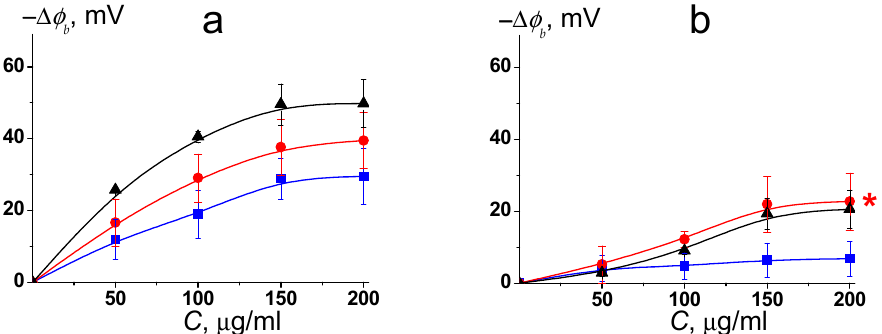
Figure 3. Decrease in the boundary potential of the membrane (– ∆ ϕ b ) vs. the concentration ( C ) of compounds 4 ( black curves ), 20 ( blue curves ), and 22 ( red curves ) in the bilayer bathing solution. The membranes were made of DPhPC ( a ) and DPhPG ( b ), bathed in 0.1 M KCl (5 mM HEPES, pH 7.4), and modified by K + -ionofore, nonactin. The transmembrane voltage was 50 mV. * The absolute ∆ ϕ b - values in the presence of compound 22 might be overestimated due to the increase in transmembrane current due to the pore-forming ability of the derivative.